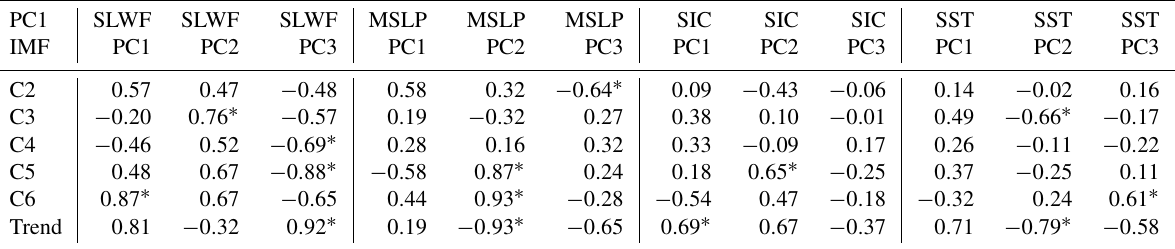
Table 2. The correlations between the first EOF sea ice drift pattern on various timescales and environmental factors (the PCs with the highest correlation values greater than 0.6 are marked with an